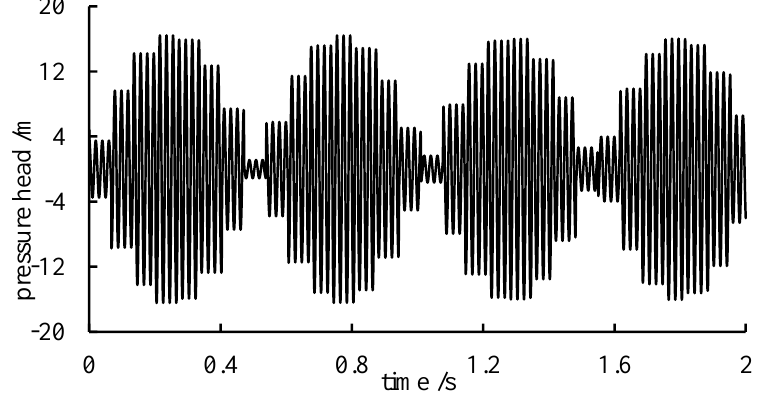
Figure 10. Pressure variation at the center of the system.